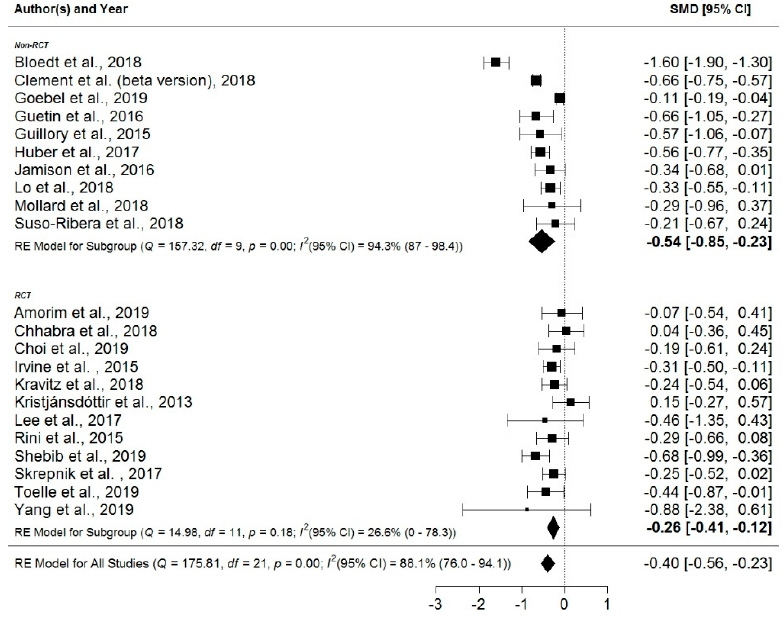
Figure 7. Funnel plot. Assessment of Quality of the Apps Only five apps were available on Google Android Market or Apple App store. Most of these apps—except one—were either not freely accessible to users or geo-locked (only available to users in a specific country or region). We requested access to the apps from their corresponding authors and received feedback from two authors, of whom one offered a pdf layout of the app as the original app